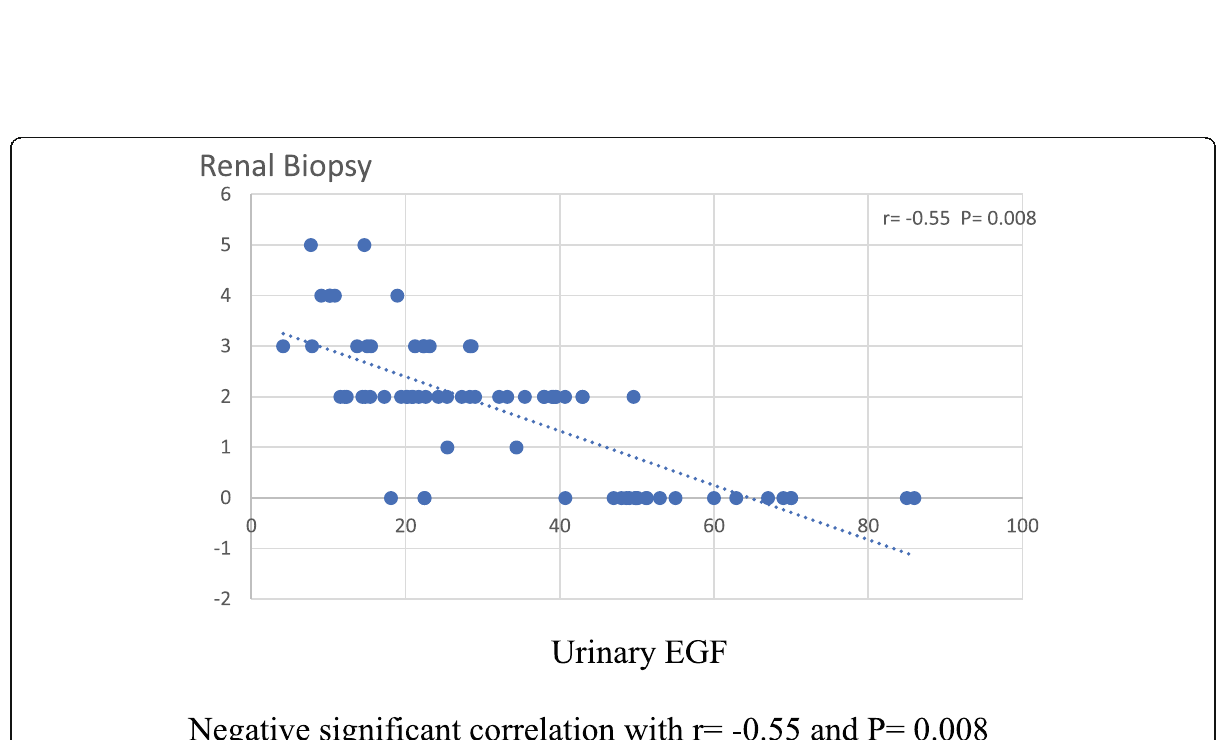
Fig. 2 Correlation between the histological renal biopsy and urinary EGF. Negative significant correlation with r = − 0.55 and P =